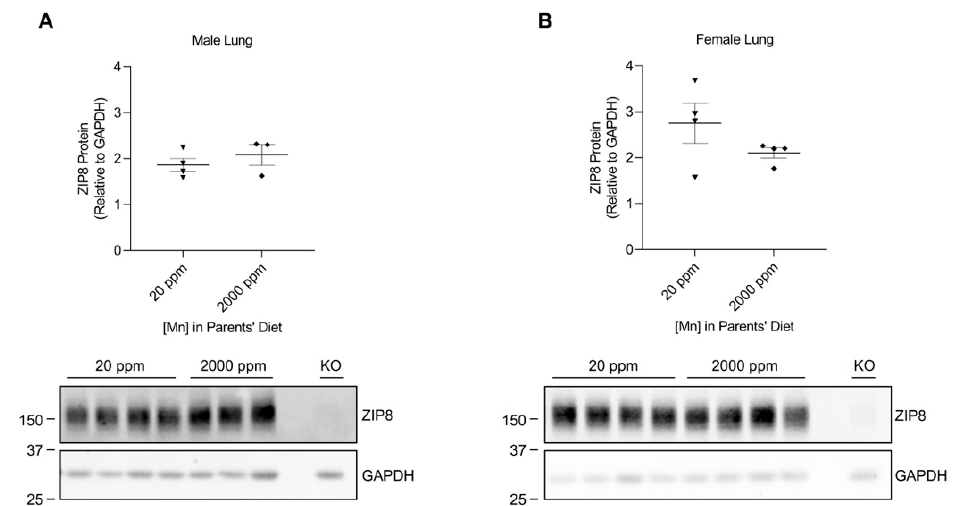
Figure 2. Comparison of ZIP8 protein expressions in the lung between the control and high-manganese diet groups. Lung samples were collected from pups at 3 weeks of age. Expression of ZIP8 in male ( A ) and female ( B ) pups that were born from and fed by mothers on 20 ppm manganese and 2000 ppm manganese diets were analyzed by Western blot analyses ( n = 3–4/group). Equal amounts of protein (50 µg for male lung samples and 102 µg for female lung samples) were assessed. Blots include the lung sample from a female, 6-week-old Zip8 -KO mouse (fed a traditional rodent diet) as a control to validate the anti-mouse ZIP8 antibody. Quanti fi cation of ZIP8 levels were determined using GAPDH as the loading control. Data are expressed as mean ± SEM.